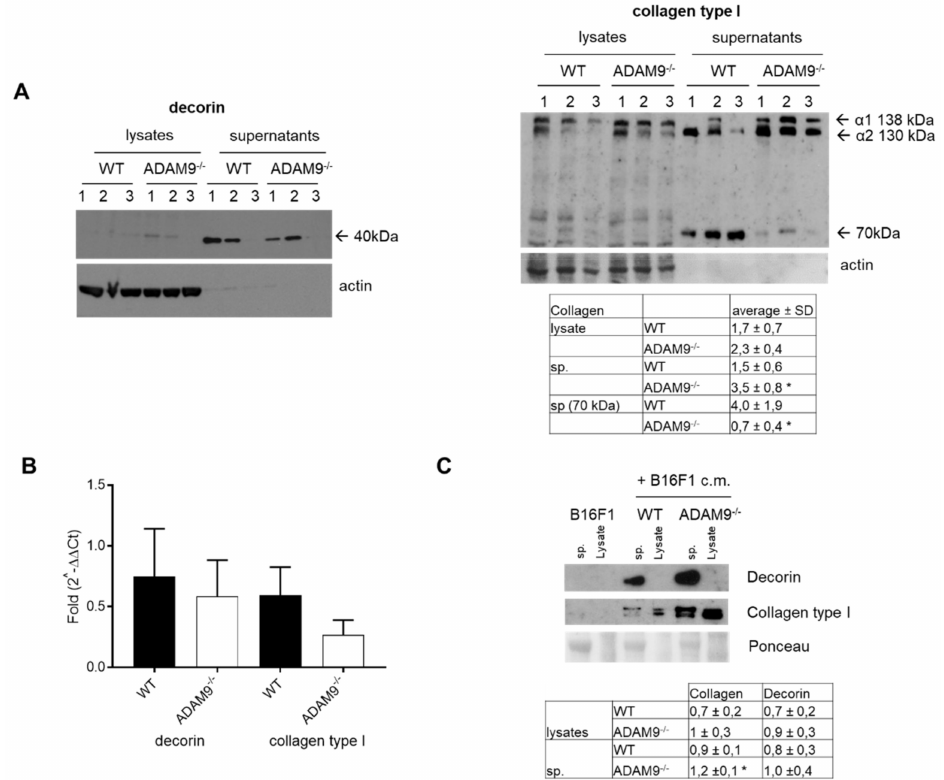
Figure 2. Expression of decorin and collagen type I in ADAM9 deficient fibroblasts. ( A ) Immunoblot analysis of decorin and collagen type I in cell supernatants and lysates from monolayer cultures of ADAM9 deficient or wild type dermal fibroblasts. Actin was used as a control. Underneath, in the table, is the average densitometric analysis after normalization to control ( n = 3; * < 0.03–4) ( B ) Quantitative real-time PCR analysis of decorin and collagen type I was performed using S26 as an internal control for normalization of transcripts. Data are mean values ± SEM (average of 6 di ff erent fibroblasts cultures per genotype). ( C ) Immunoblot analysis of decorin and collagen type I in cell supernatants (sp.) and lysates from monolayer cultures of B16F1, ADAM9 − / − , or wild type dermal fibroblasts, without or with stimulation B16F1 conditioned medium (B16F1 c.m.). Underneath, in the table, is the average densitometric analysis of collagen and decorin after normalization to control ( n = 4; * < 0.01).